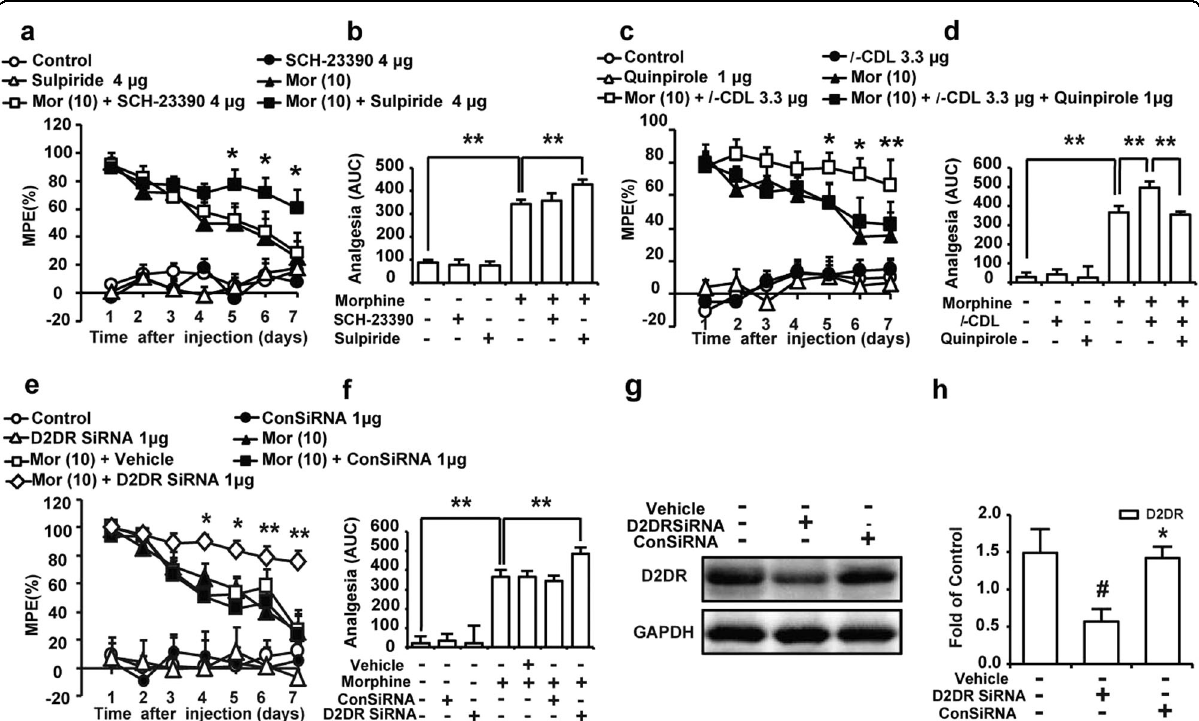
Fig. 2 Antagonism of spinal D2DR, but not D1DR, attenuates morphine tolerance and a D2DR agonist reverses the inhibitory effects of l- CDL on morphine tolerance in mice. a , b Intrathecal administration of the D2DR antagonist sulpiride (4 μ g/10 μ l) attenuated morphine tolerance, while the D1DR antagonist SCH-23390 (4 μ g/10 μ l) did not attenuate morphine tolerance. Neither sulpiride nor SCH-23390 affected the pain threshold of naïve mice. The analgesia was further reported in area under the curve (AUC) units. Data are presented as means ± SE. n = 12, * P < 0.05, ** P < 0.01, compared with the morphine group. c , d Intrathecal administration of the D2DR agonist quinpirole (1 μ g/10 μ l) abolished l -CDL (3.3 μ g/10 μ l)-induced inhibition of morphine tolerance in mice. The analgesia was further reported as area under the curve (AUC) units. Data are presented as means ± SE. n = 12, * P < 0.05, ** P <0.01, compared with the group treated with the combination of morphine, l -CDL and quinpirole. e , f Multiple